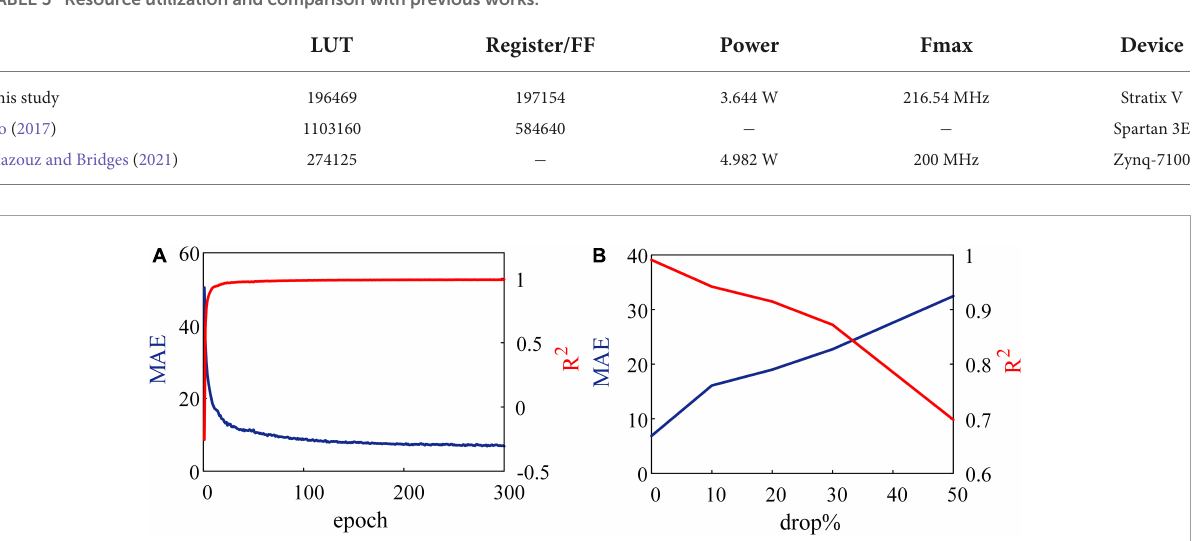
TABLE 5 Resource utilization and comparison with previous works.